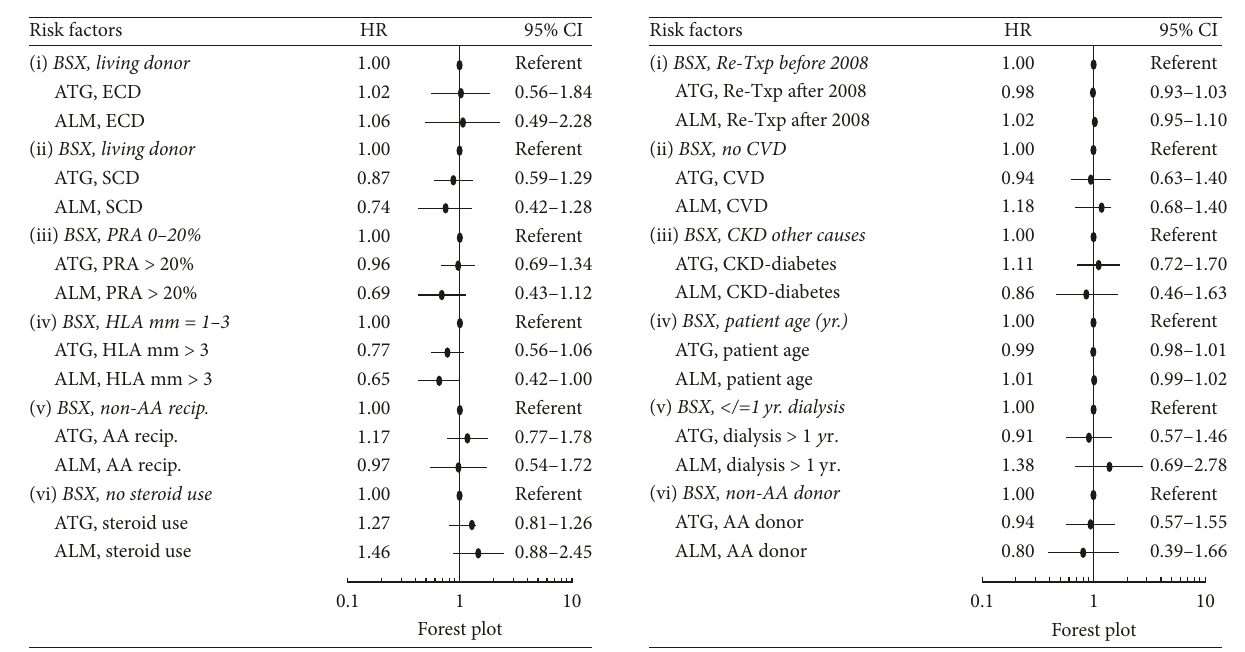
Figure 3: Patient death in 5 years of kidney retransplant, Cox model with